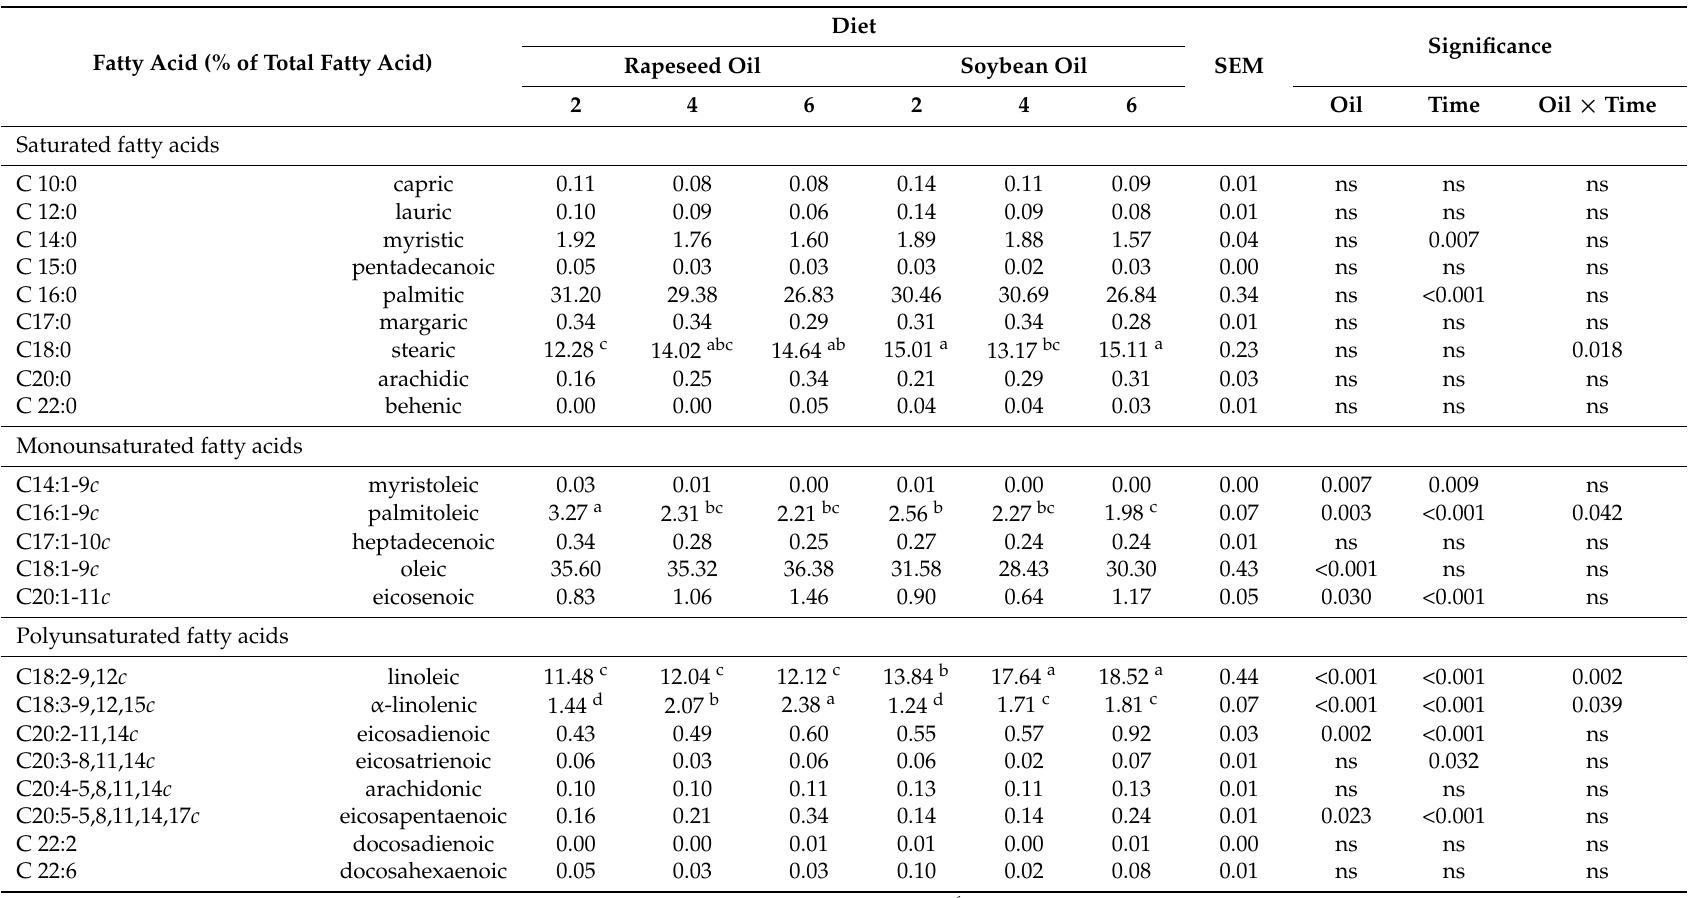
Table 4. Fatty acid composition of